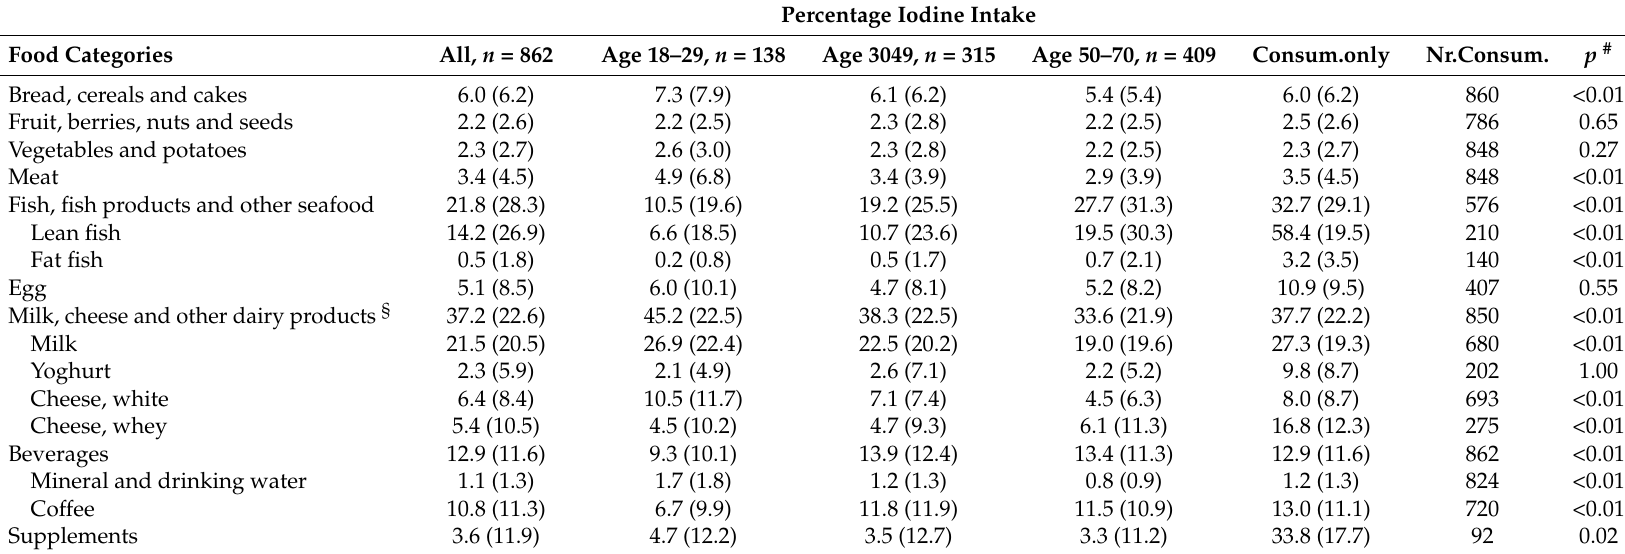
Table 3. Percentage iodine intake from different food categories, in men, different age groups and for the consumers only, mean, and